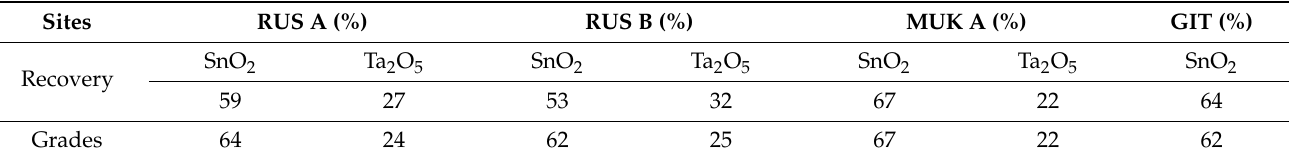
Table 1. Artisanal processing results.